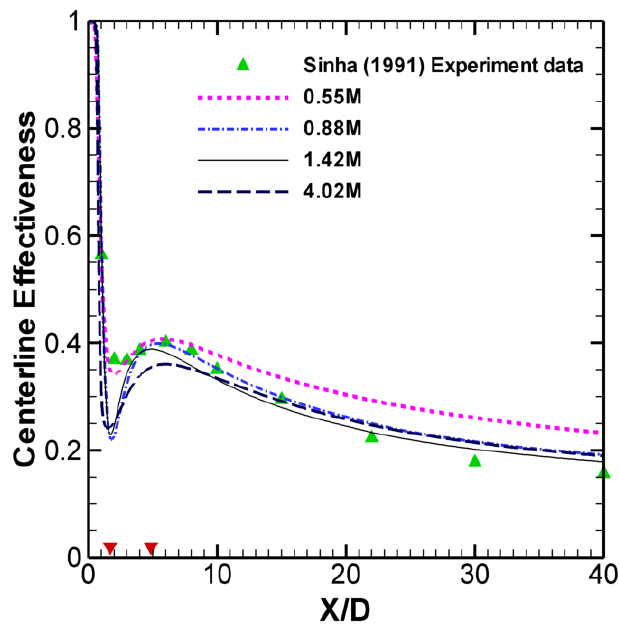
Figure 2. Grid independence and validation (Br = 1, Dr = 2).